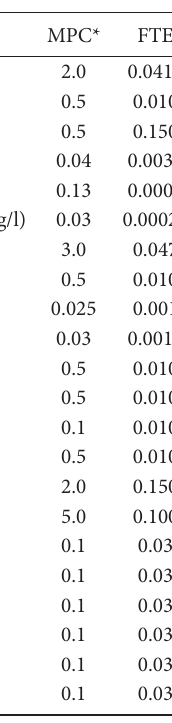
Table 1.Chemical analysis of the final treated effluent (FTE) and maximum permissible concentrations (MPC) standard. The Domžale-Kamnik central WWTP with an upgrade of a new aerobic biological rate of achievement of tertiary treatment by SBR technol- ogy treating has been shown to be very